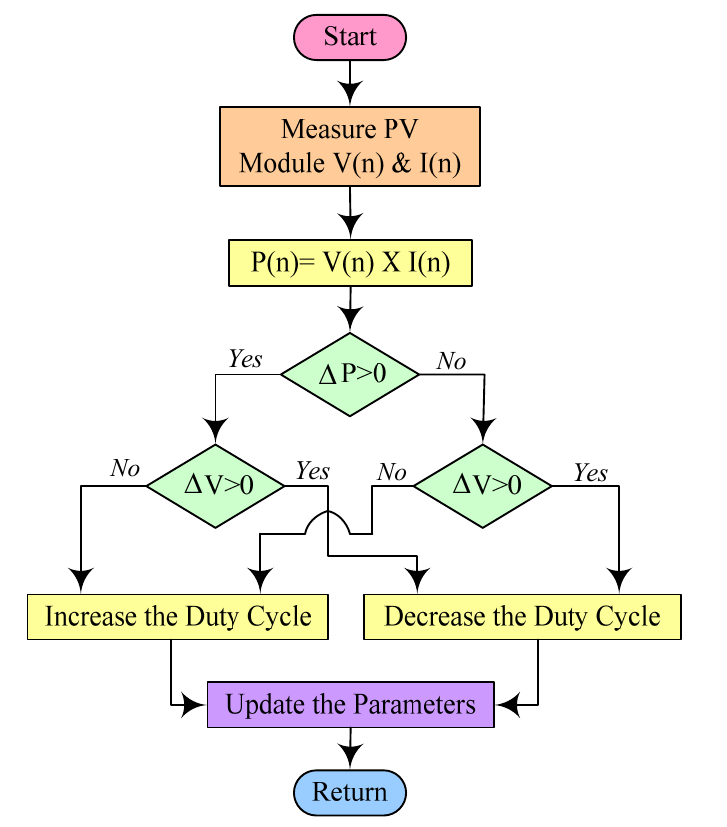
Figure 8. P&O-based MPPT technique [24].